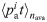
Reduced networks.Scheme of the 〈pait〉nava for the reduced networks. (A), (B) and (C) show the activation probabilities 〈pait〉nava coming from the original three cases, K = 10, 100 and 1 000 respectively, distributed in fully connected reduced networks of size N′ = 16. (D) show the comparison between 〈pait〉nava obtained from the original networks, circles, and the FS calculated from the simulations of the reduced networks, dashed lines, both normalized by the area under the curve. The colours blue, red and black are related to K = 10, 100 and 1 000 respectively. (E) Example of patterns observed in networks with K = 10. The pattern that was observed more frequently is located in the top, whereas the pattern that was observed less frequently is located in the bottom. The vertical line separates the initial time, when the active element was chosen randomly.